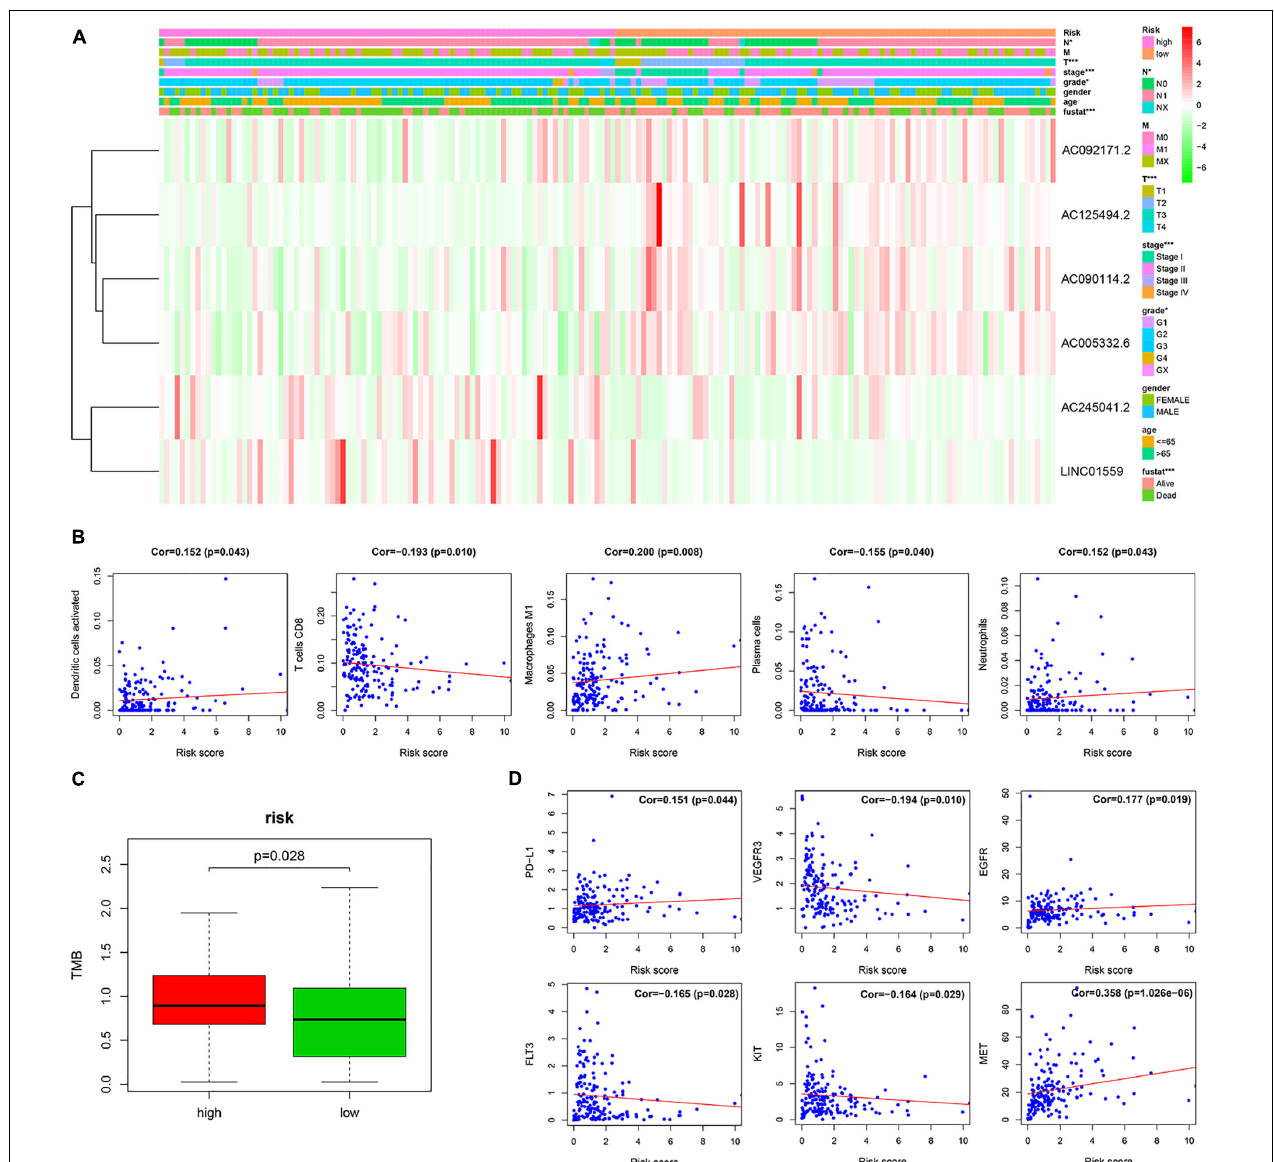
FIGURE 5 | The correlation of the risk score with the clinical traits, immune cells and therapy targets. (A) Correlation of risk group and clinical traits. (B) The correlation between the risk score and immune cells. (C) The TMB of PC patients in the high-risk and low-risk groups. (D) The correlation between the risk score and therapy targets (* p < 0.05; *** p < 0.001; ns, not significant).